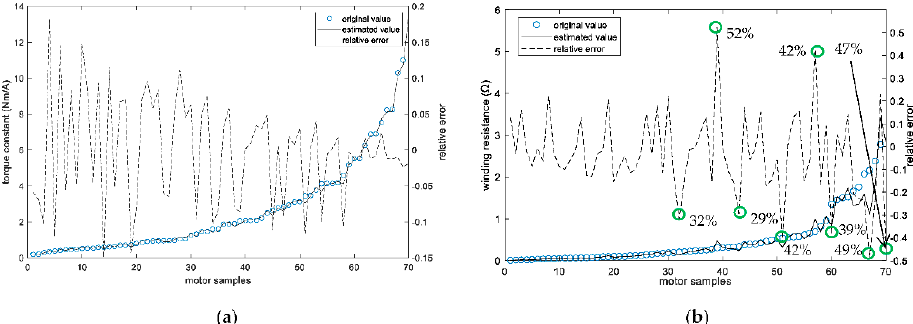
Figure 3. The original parameter values and the estimated parameter values. ( a ) The original and estimated values of torque constant K tm . ( b ) The original and estimated values of winding resistance R m .